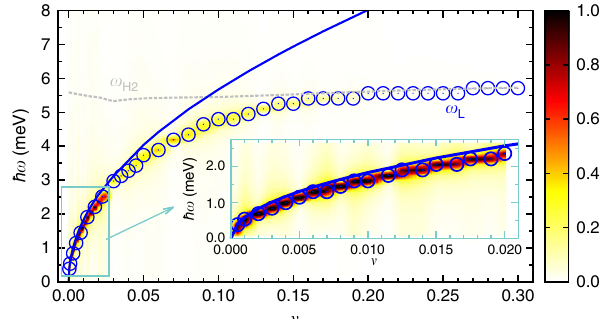
w e k c k l s denotes the normal state Hamilto- where H 0 ¼ P l c k l s k l s creates electrons with momentum k , band index l nian and c w k l s and spin s . The first sum in equation (1) is taken over the set W of momentum vectors with | e k l | r : o c ¼ 50 meV, o c being the cutoff frequency. The gaps D 1 and D 2 in the two bands are